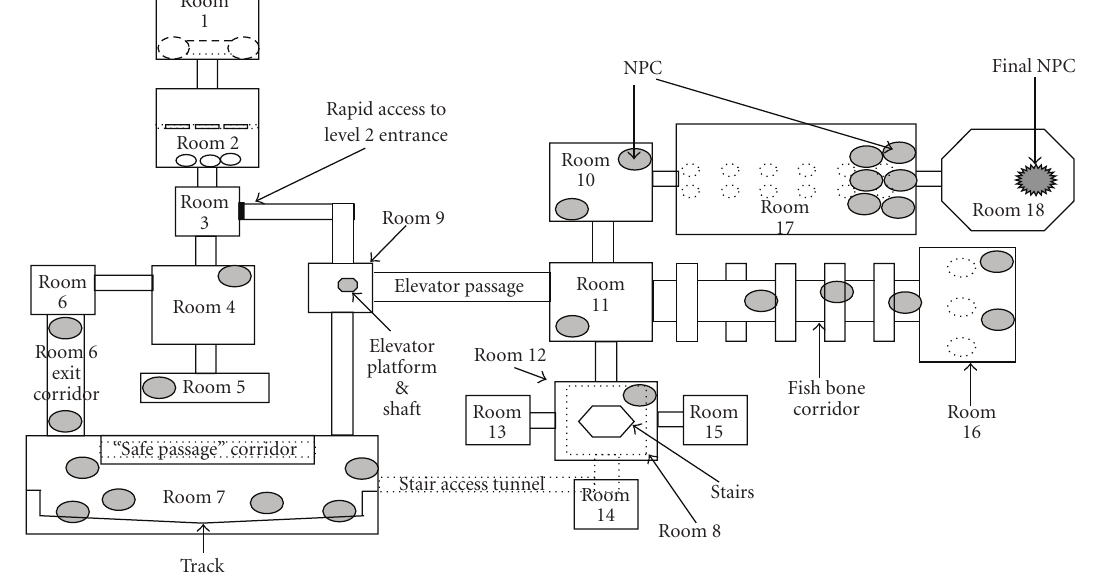
Figure 1: Level design